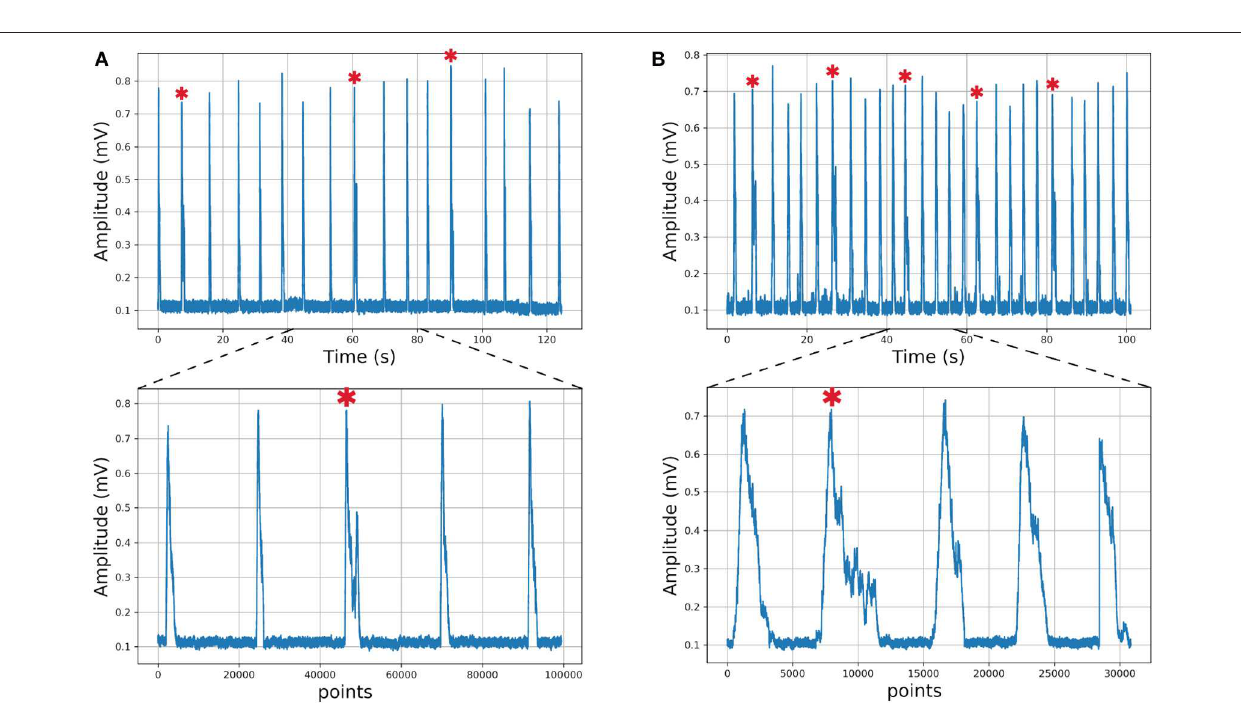
FIGURE 5 | Respiratory rhythm. (A) Control record and (B) Bombesin record. In asterisk (*) are shown